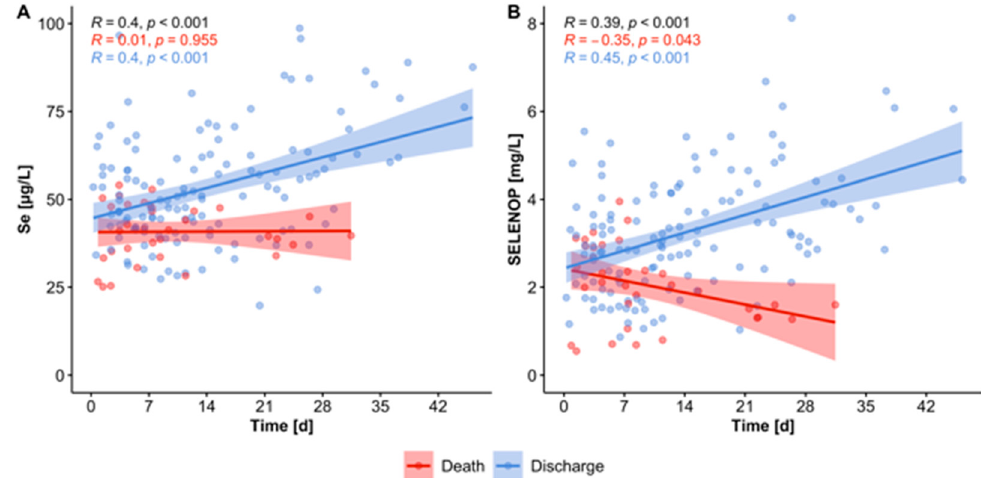
Figure 3. Time-resolved changes in Se status in surviving vs. deceased patients. Serum samples from COVID-19 patients were analyzed for ( A ) total Se, and ( B ) serum SELENOP concentrations. Surviving patients (blue dots) showed increasing Se status with time, with respect to both serum Se and SELENOP. In comparison, Se status remained constant, and SELENOP concentrations declined, respectively, in non-surviving patients (red dots). All tests were two-sided and p -values < 0.05 were considered statistically significant; R: Spearman correlation coefficient (2-sided, 2-tailed); overall, death- and discharge-related correlations of Se status vs. time are indicated in the upper left corners.